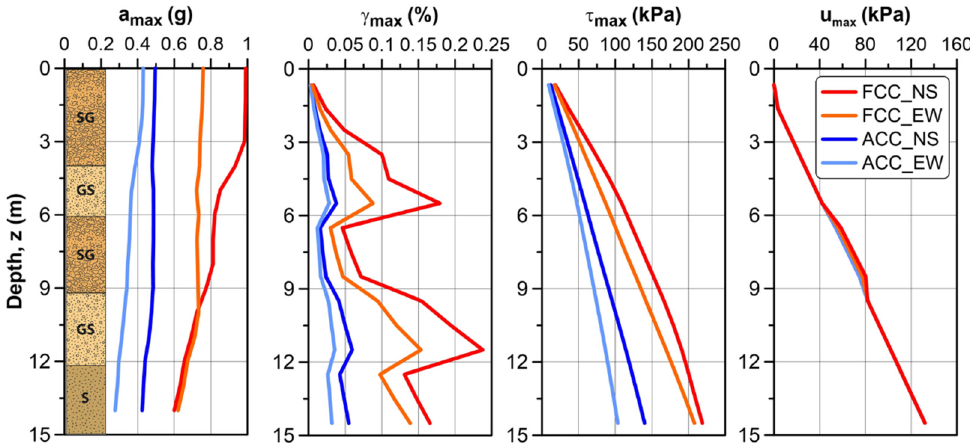
Figure 22. Vertical profiles of the maximum acceleration, shear strain, shear stress and pore water pressure; SG: sandy gravel; GS: gravel and sand; S: sand.